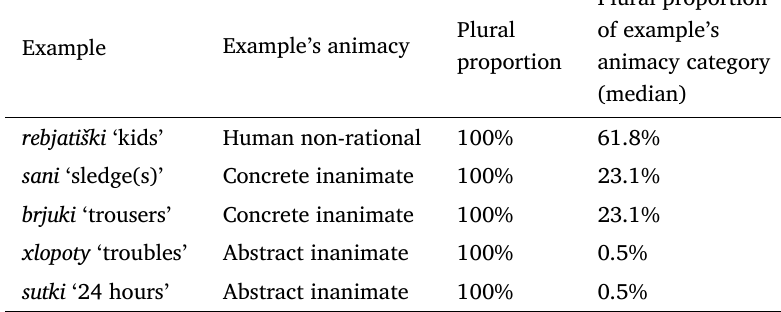
Table 5: Pluralia tantum in the